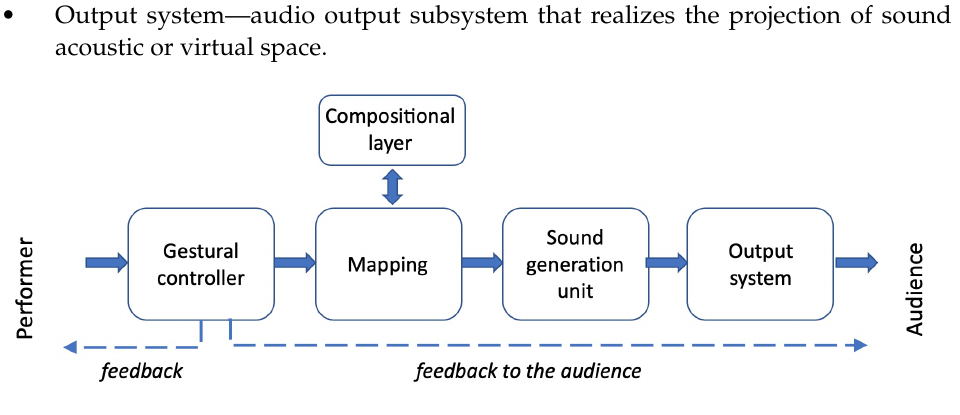
Figure 3. Scheme of a Music Performance